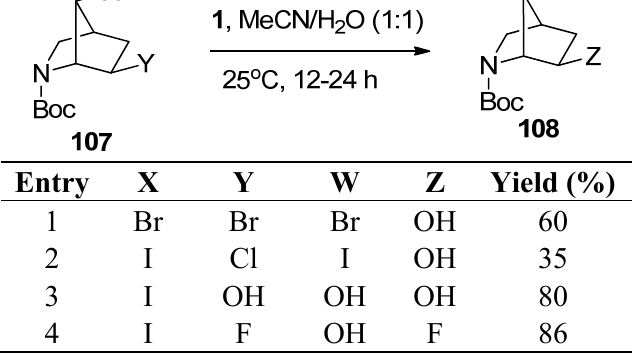
Table 6. Hydrolysis of β -halo-N-aloxycarbonyl-2-azabicyclo[2.2.1]heptanes with F-TEDA-BF